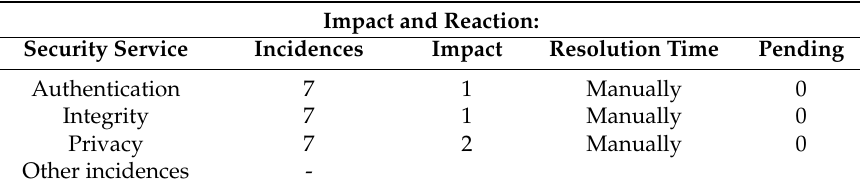
Table 11. Citizen protection impact and reaction.